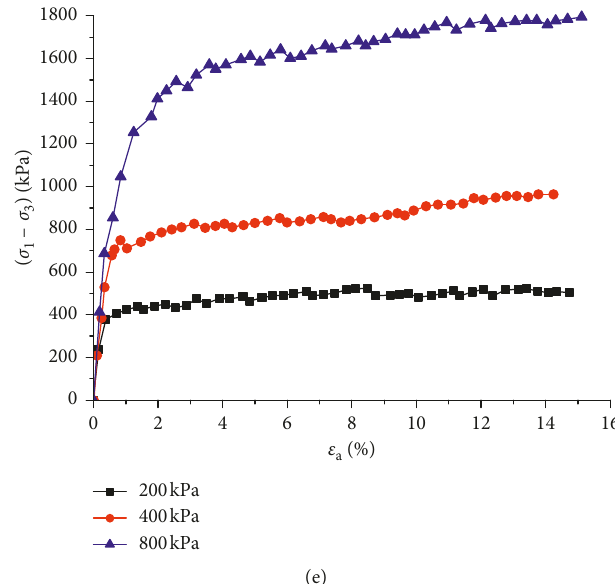
Figure 2: Stress-strain curves measured at different rock content. (a) 0%. (b) 10%. (c) 30%. (d) 50%. (e)